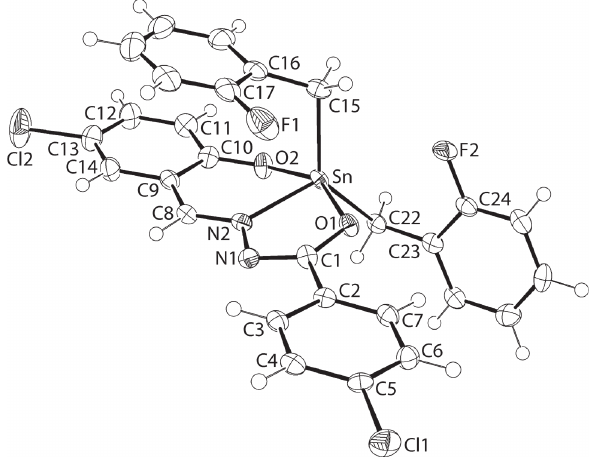
Table 1: Data collection and